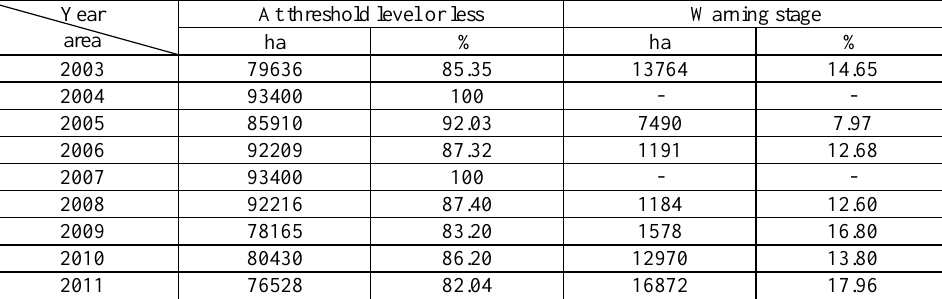
Table 4. The extent of areas under warning based on SAR during